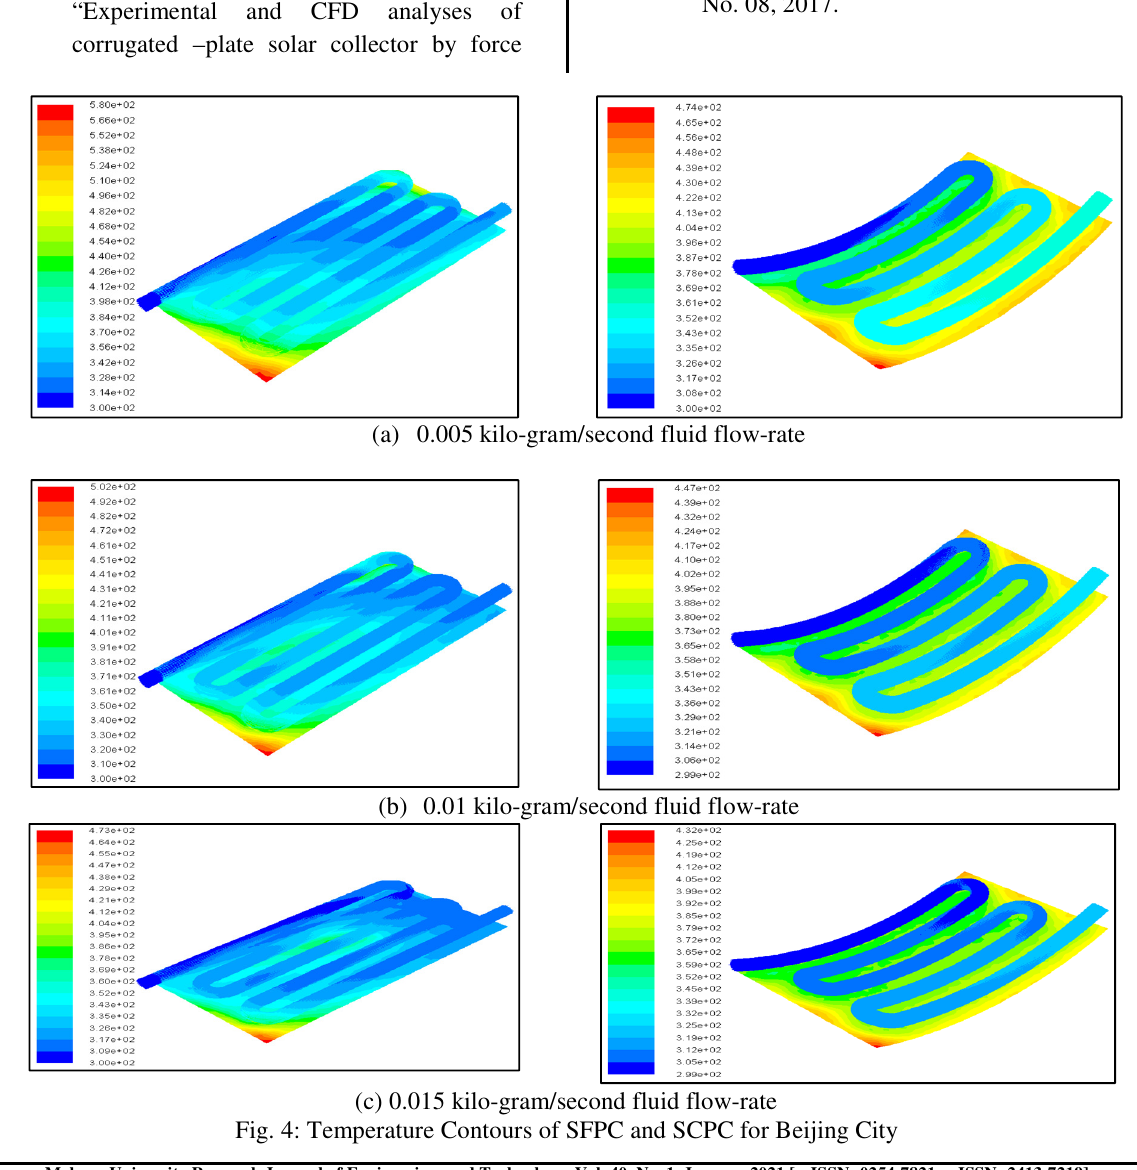
Fig. 4: Temperature Contours of SFPC and SCPC for Beijing